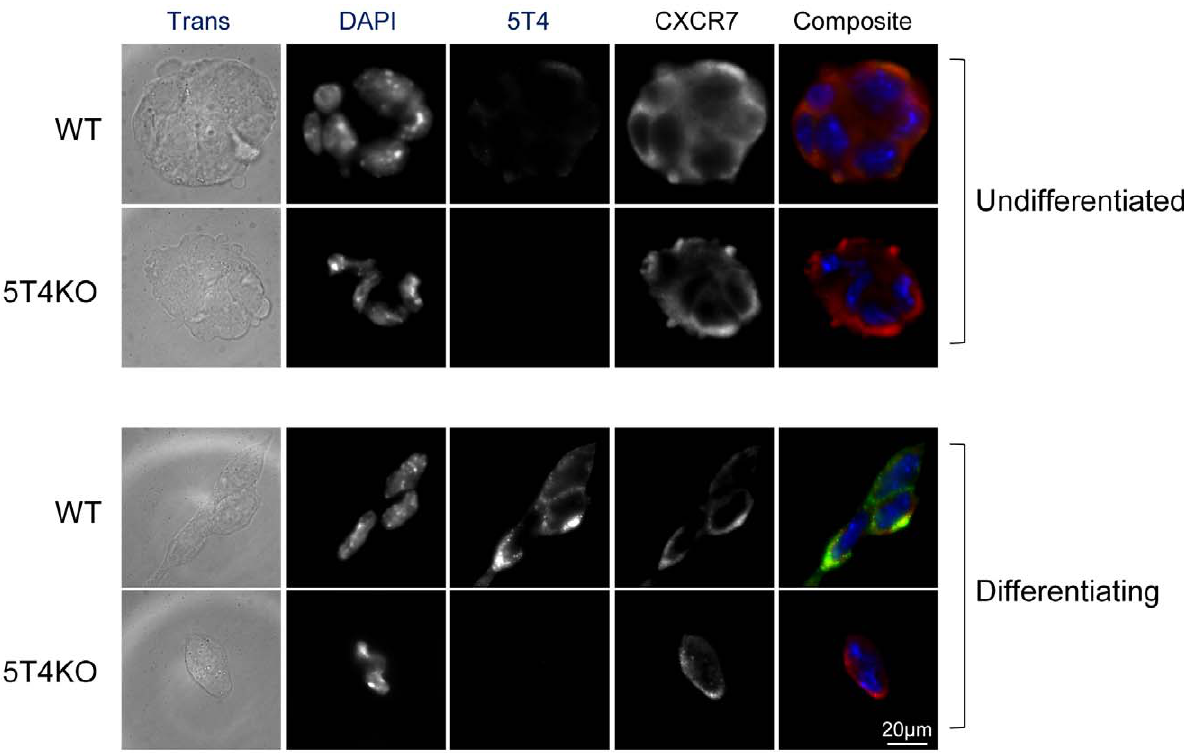
Figure 11. 5T4 is not required for CXCR7 surface expression. Immunofluorescence detection of 5T4 and CXCR7 in undifferentiated and differentiating WT and 5T4KO-ES cells (5T4 = green, CXCR7 = red). Cell surface expression of CXCR7 is high in undifferentiated ES cells (either WT or 5T4KO). In 3 day differentiating WT-ES cells, CXCR7 is relatively downregulated from the cell surface whereas in differentiating 5T4KO-ES surface CXCR7 is